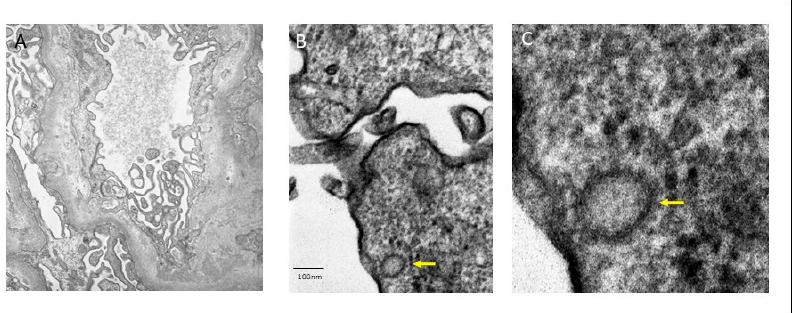
Figure 3. Electron-dense deposits with mesangial and para-mesangial location ( A ). Viral particles with a double contour membrane and a crown of 120 nm diameter in podocyte cytoplasm (arrows) ( B , C ).